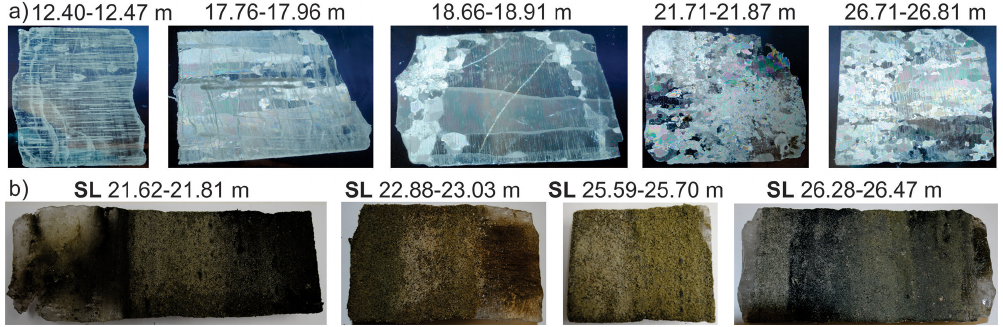
Figure 3. (a) Images of thick sections of Lake Vida ice between two sheets of polarized film. At 12.40–12.47m, the entire section is a single ice crystal. With depth the average grain size of ice crystals decreases to < 1cm. (b) Photographs of sediment sections SL21.62, SL22.88, SL25.59, and SL26.28.